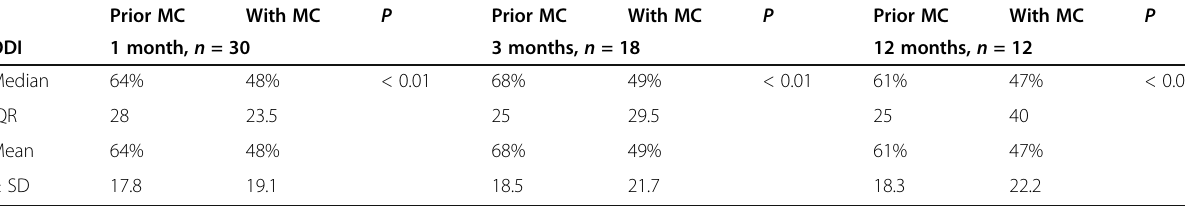
Table 8 Medical cannabis effect on disability after 1, 3, and 12 months in Italian fibromyalgia patients Prior MC With